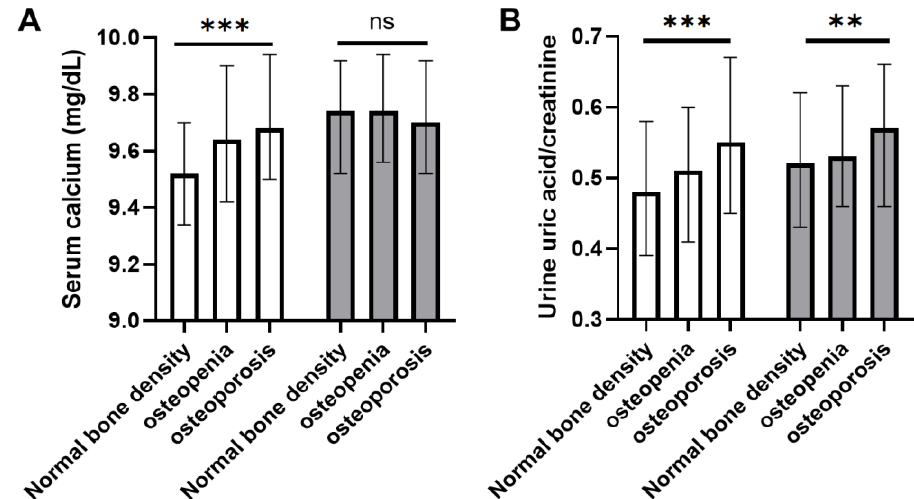
Figure 3. Serum calcium ( A ) and urine uric acid ( B ) levels according to bone densitometry values in the cross-sectional cohort. White bars and gray bars represent premenopausal and postmenopausal cohorts, respectively. ns, not significant; ***, p < 0.001. **, p < 0.01